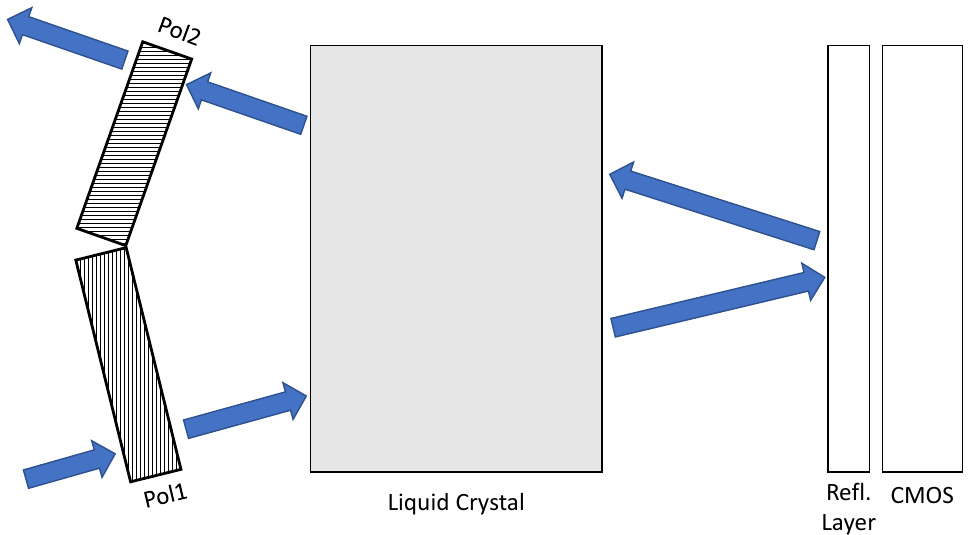
Figure 5. Operating Principle of Liquid Crystal On